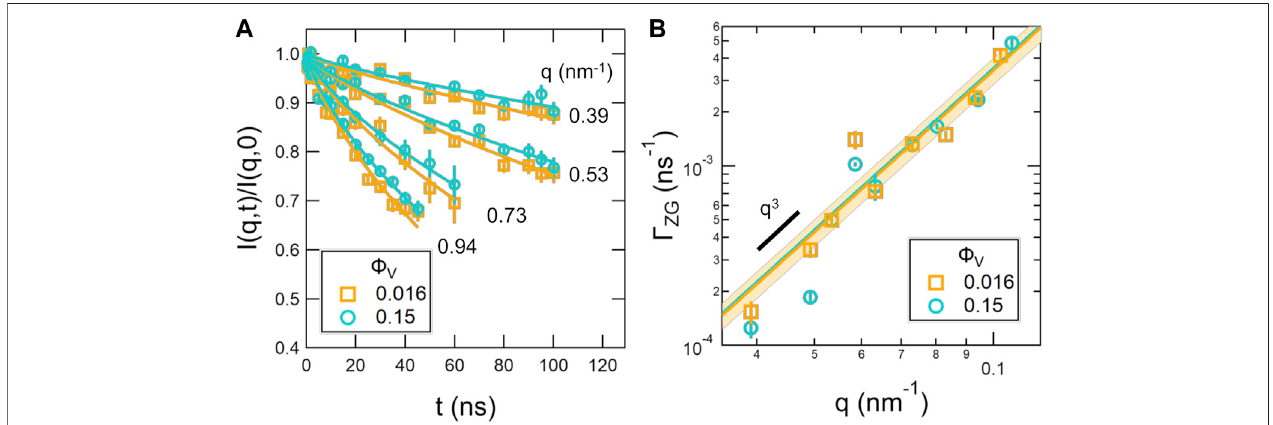
FIGURE6| Normalizedintermediatescatteringfunctions, I ( q , t )/ I ( q ,0) (A) andextractedrelaxationratesforthemembraneheight fl uctuations, Γ ZG (B) measuredfor the vesicle solutionswith ϕ V that vary by an order of magnitude, ϕ V = 0.016 and 0.15. The points in (A) are the measured data and the solid lines are the fi tsaccording to Eq. 16 where D s was calculated according to Eq. 11 using the experimentally determined D 0 value. Error bars on the data points represent one standard deviation. The solid lines in (B) are the fi ts, and the shaded regions are the 95% con fi dence intervals on the fi ts to Eq. 15 .